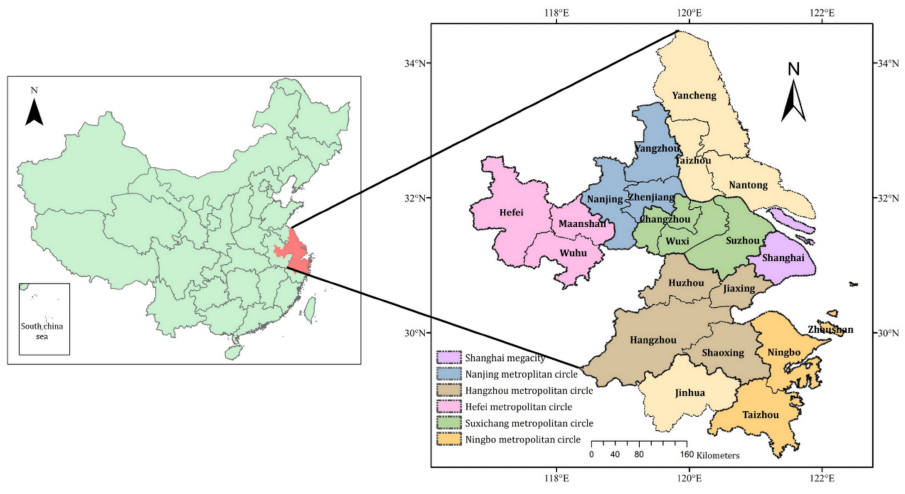
Figure 1. Yangtze River Delta Urban Agglomeration (YRDUA) study